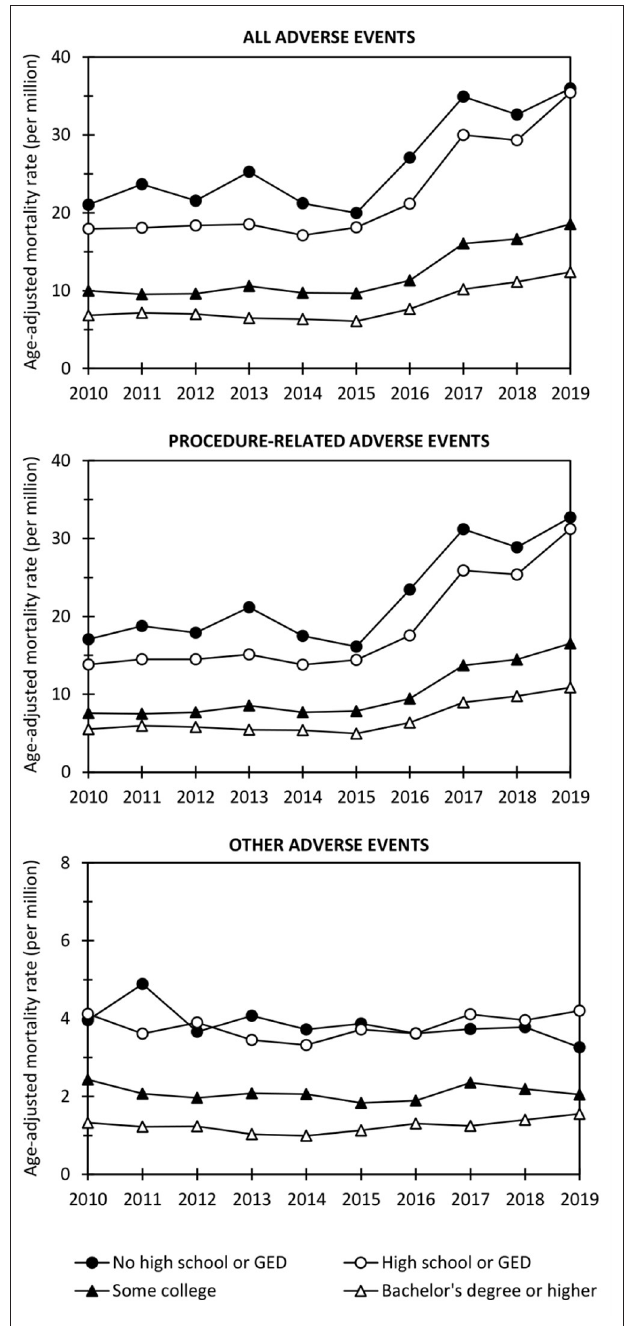
FIGURE 1 | Age-adjusted mortality rates for all adverse events, procedure-related events, and other adverse events in education categories over the period 2010–2019. GED, General Educational